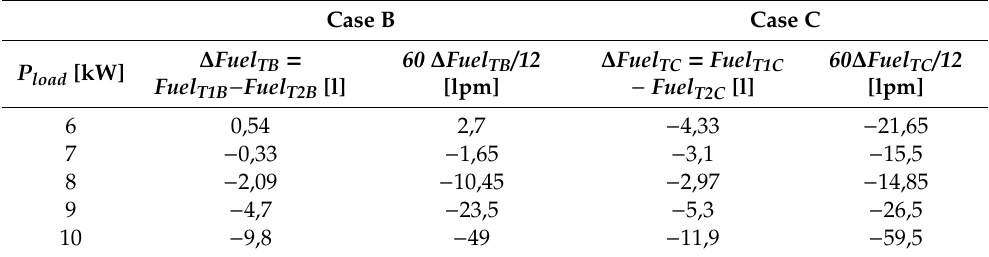
Table 5. ∆ Fuel T for the Air-LFW and Fuel-LFW strategies (Case B and C, same P RES , and di ff erent P load ).